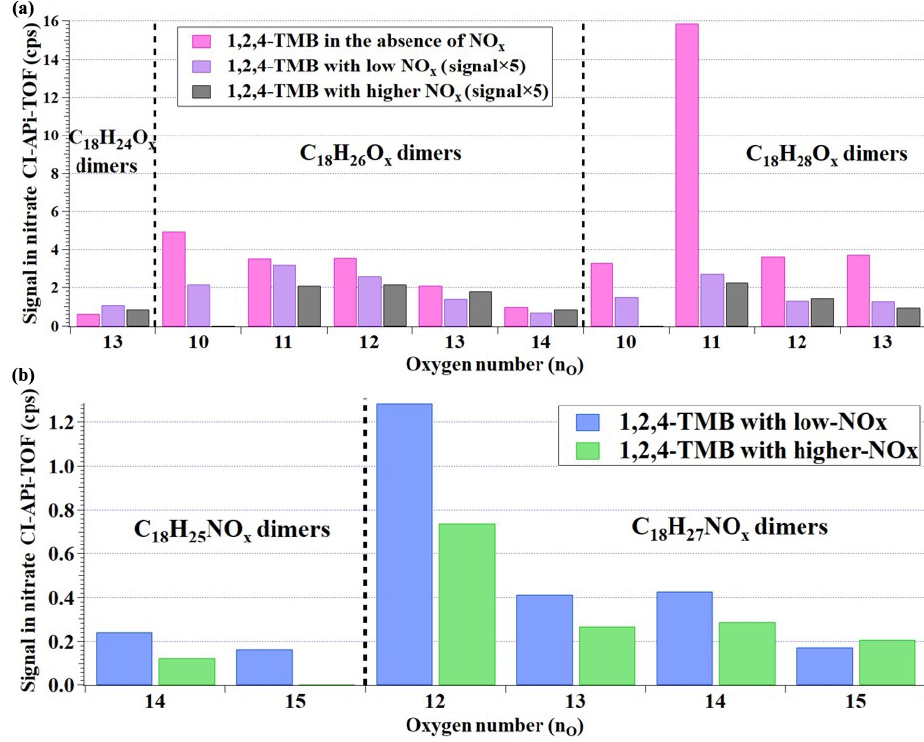
Figure 7. (a) Comparison of C 18 HOMs formed from 1,2,4-TMB oxidation with different NO x settings and (b) distribution of C 18 organon- itrates formed from 1,2,4-TMB